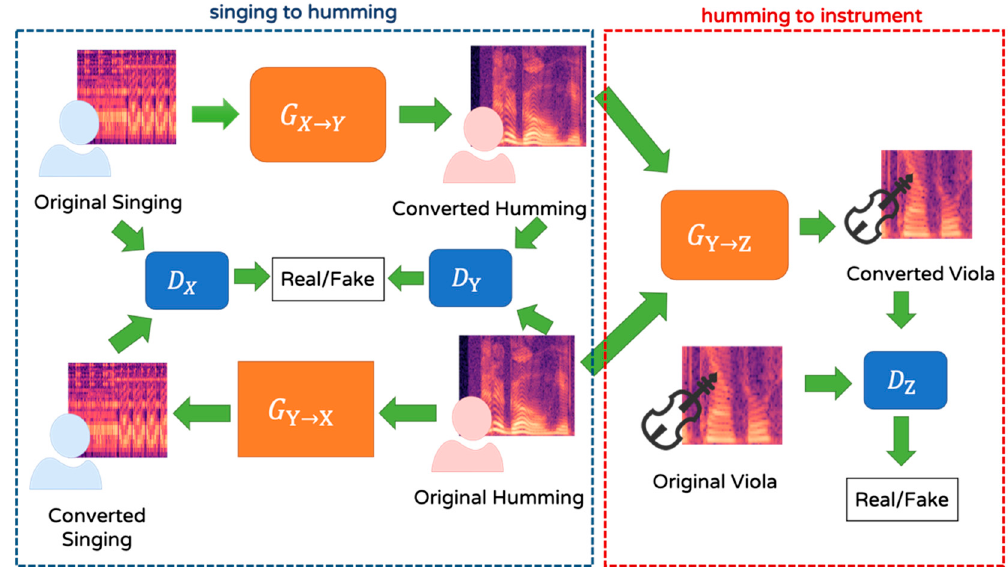
Figure 1. Dual conversion model for singing to instrument.